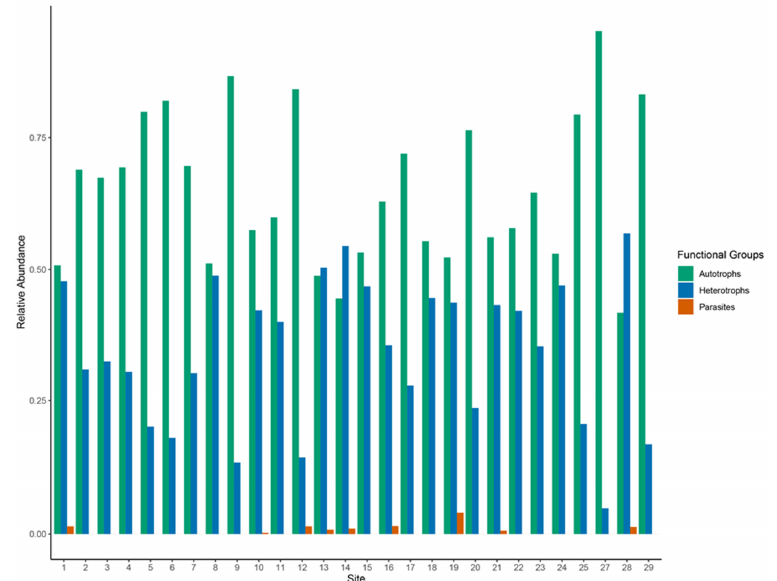
Figure 7. Relative abundance bar plot of functional groups in protists communities per sampling sites, during 5–10 October 2019, along the New River, Belize. Colors indicate functional groups— green = Autotrophs; blue = Heterotrophs; red = Parasites. Microorganisms 2022 , 10 , x FOR PEER REVIEW